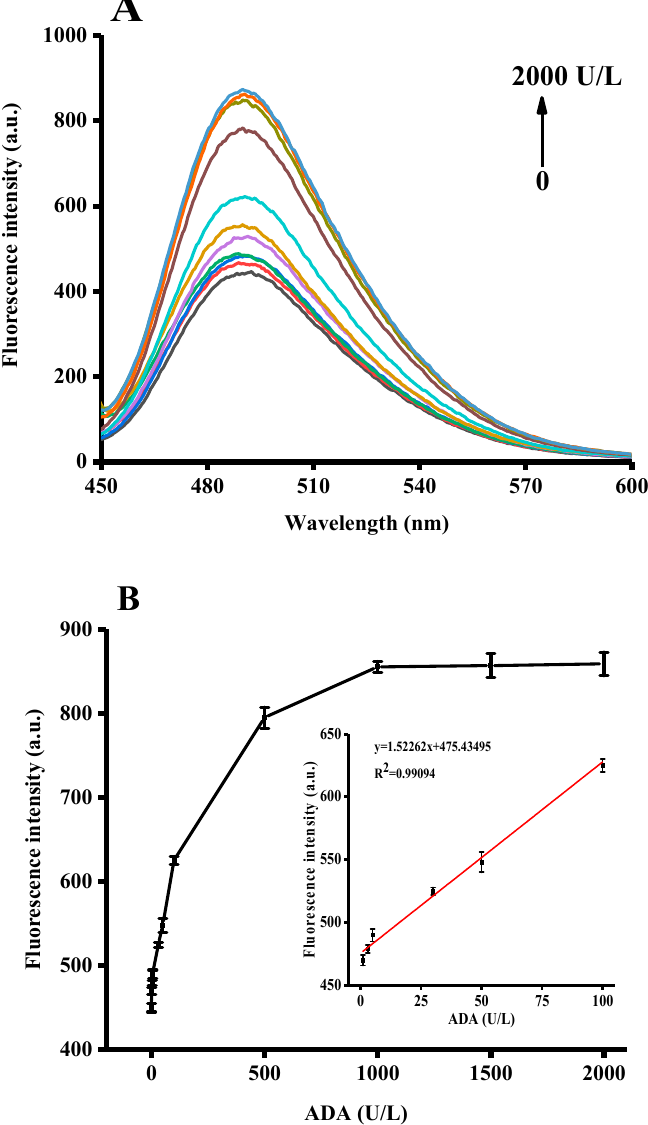
Figure 4. ( A ) Fluorescence emission spectra of aptasensor complex in the presence of increasing ADA concentrations (0, 1, 3, 5, 30, 50, 100, 500, 1000, 1500, 2000 U/L); ( B ) Change of fluorescence intensity versus ADA concentration. The inset shows the linear correlation at low ADA concentrations. Error bars were estimated from three replicate measurements. Table 1. Comparison with the currently reported methods for ADA determination.